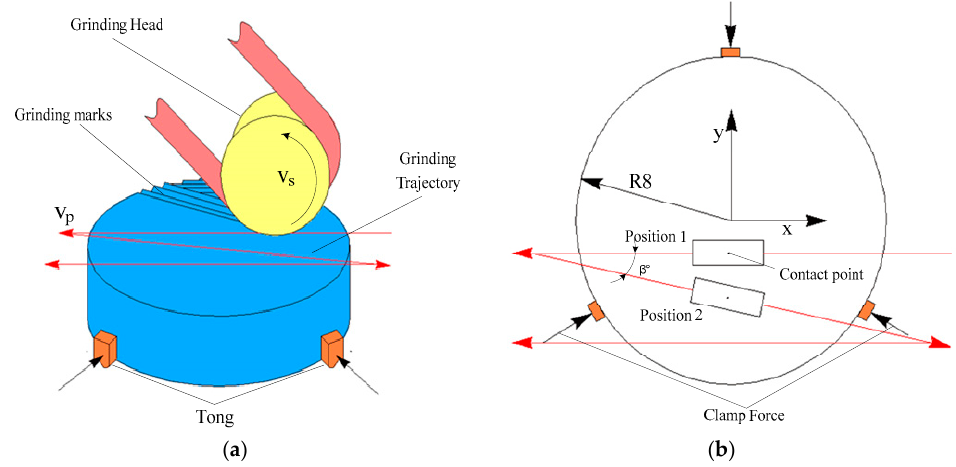
Figure 3. Z-track grinding. ( a ) Sketch of Z-track grinding; ( b ) Diagrammatic drawing of Z-track.